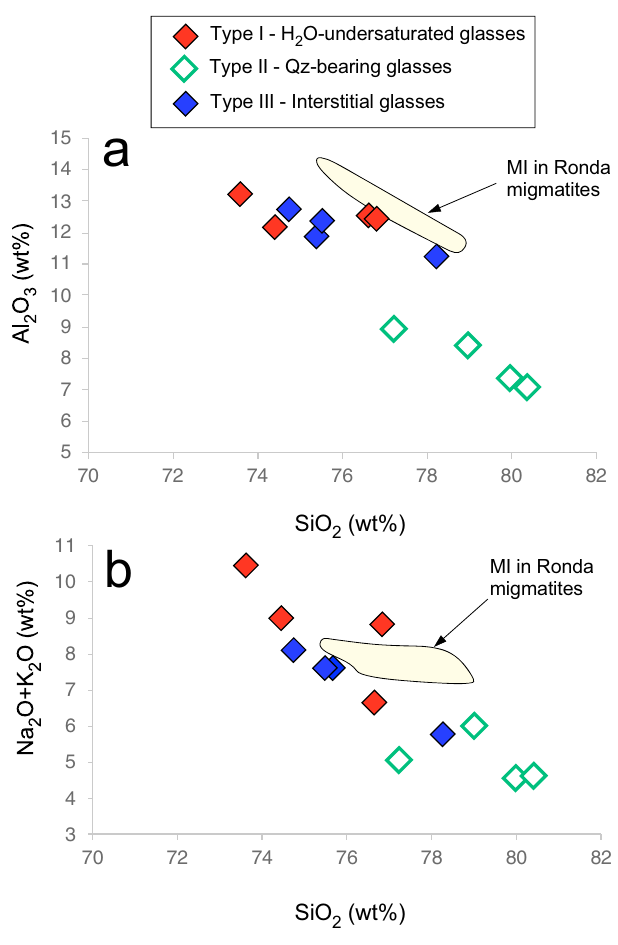
Fig. 2 | Composition of rhyolite glasses. SiO 2 vs. Al 2 O 3 ( a ) and vs. alkali (Na 2 O+K 2 O) ( b ) covariation diagrams for the three glass types recorded in the TL112a and TL112b composite xenoliths from Tallante, South-East Spain. Compo- sitions of melt inclusions (MI) from Ronda migmatites are also reported 46 . Abbre- viations: Qz =